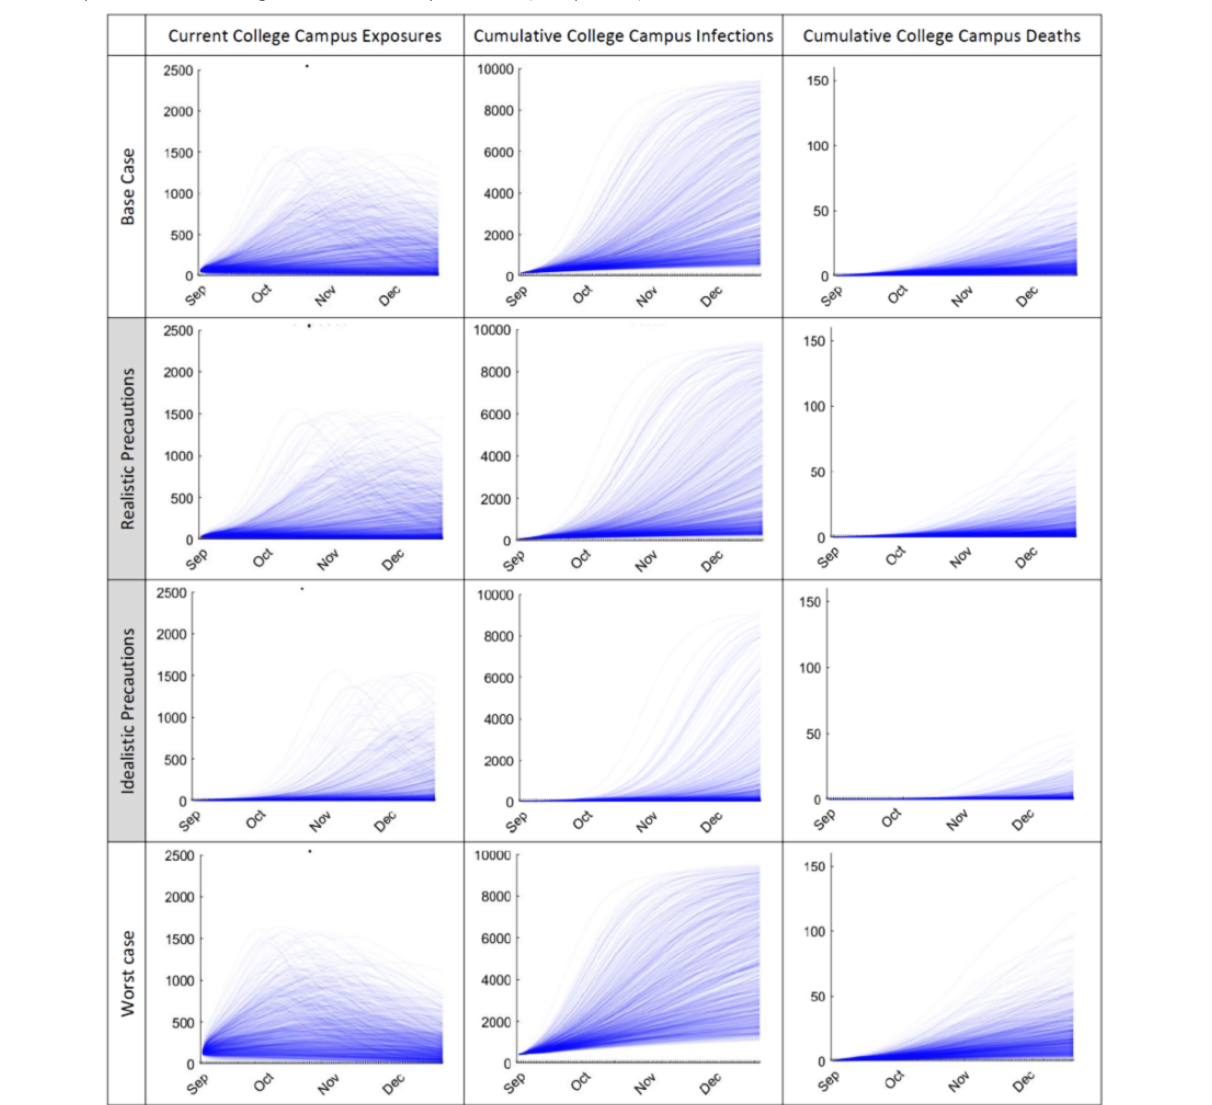
Figure 1. Predicted number of college students per 10,000 who are currently exposed to COVID-19, have been infected to date, and have died to date over a 16-week fall 2020 semester (urban university example). Top row: base case scenario assuming no semester initiation precautions and disease prevalence of 2% among arriving students (equal to national and regional averages). Shaded middle rows (most likely cases): realistic (1%) and idealistic (0.1%) initial prevalence scenarios assuming good or great screening-on-arrival precautions, adherence, and effectiveness. Bottom row: worst case scenario (5% prevalence) assuming little-to-no arrival precautions, compliance, and